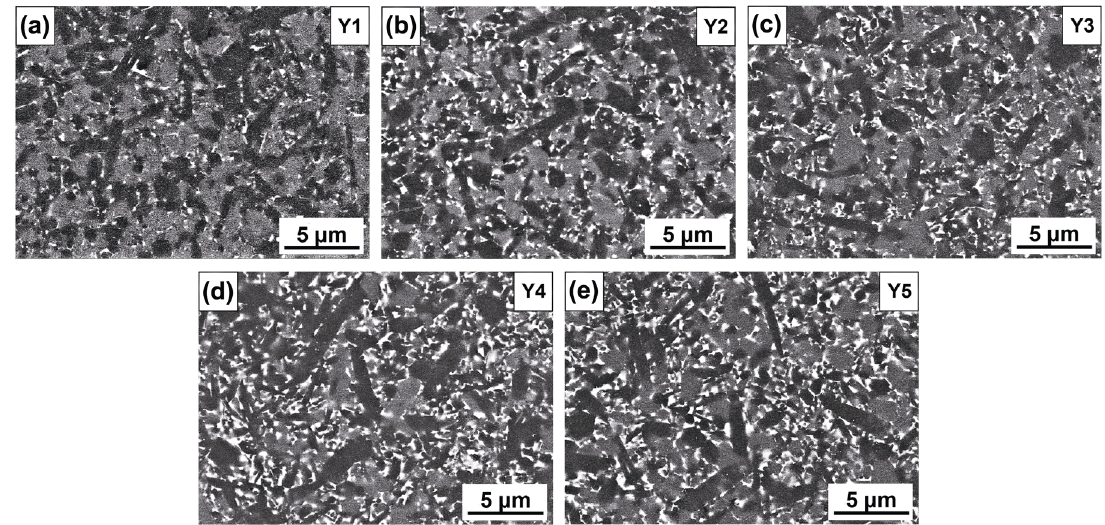
Fig. 8 Microstructure of α / β -SiAlON ceramics with different amounts of excess Y 2 O 3 synthesis additives ( m = 1.7, n = 1.0, z = 0.7, synthesized at 1750 ℃ ) obtained under SEM–BSE mode: samples (a) Y1, (b) Y2, (c) Y3, (d) Y4, and (e)